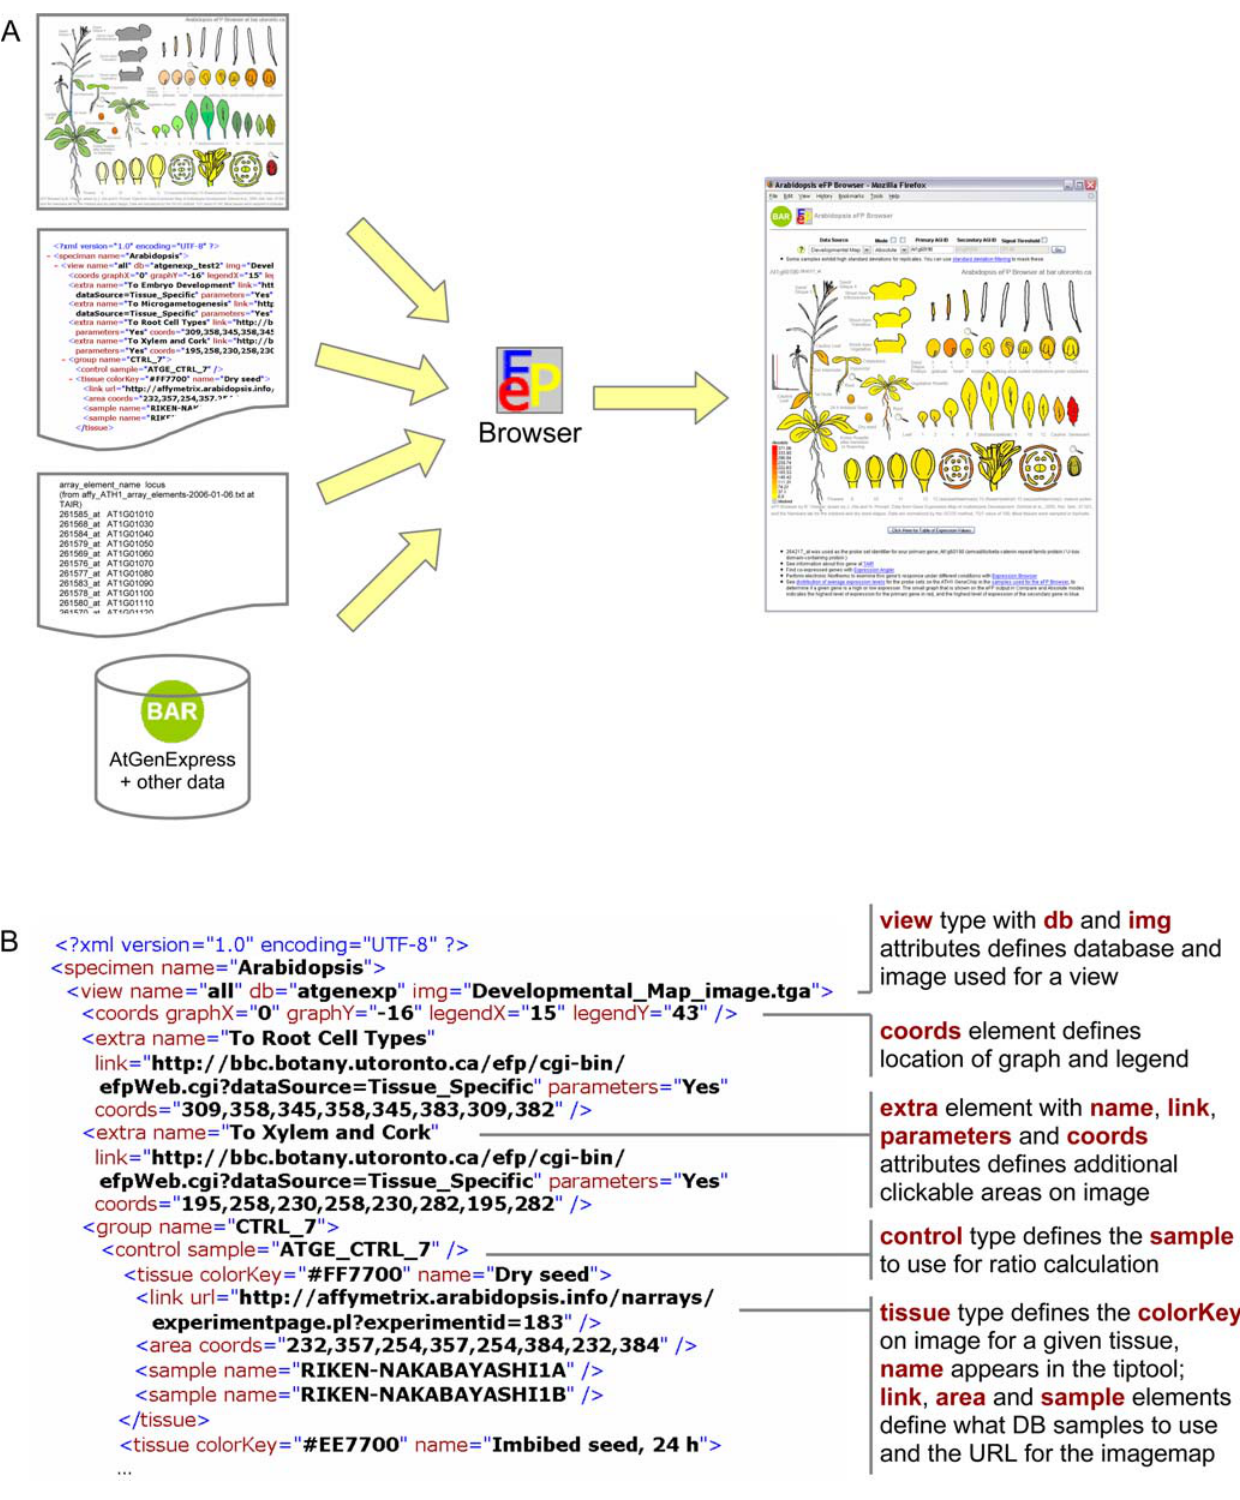
Figure 1. Representation of eFP Browser implementation. A . Schematic of browser inputs showing from top to bottom on the left the input image that forms the basis for the output, the XML control file, the identifier to probe set lookup, and the expression database. These are used by the eFP Browser to generate the output image upon user input. B . Snippet of the XML control file with significant tags highlighted.